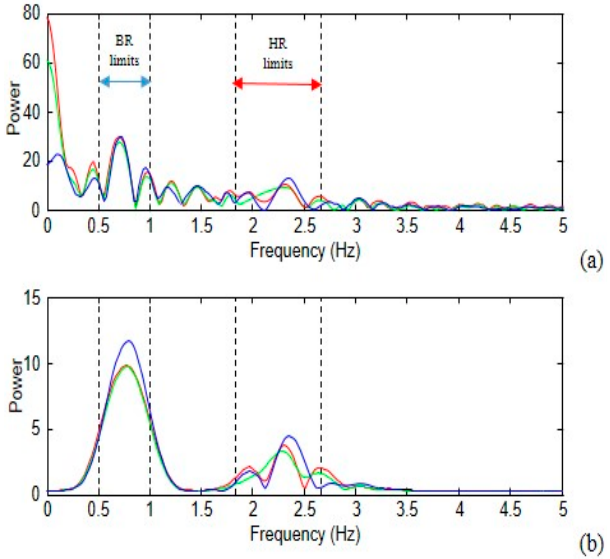
Figure 5. Spectrum analysis of the three RGB-channels, ( a ) unfiltered spectrum and ( b ) filtered spectrum, a sliding-windows of 6 s (the dashed lines are the limits for the heart and breath